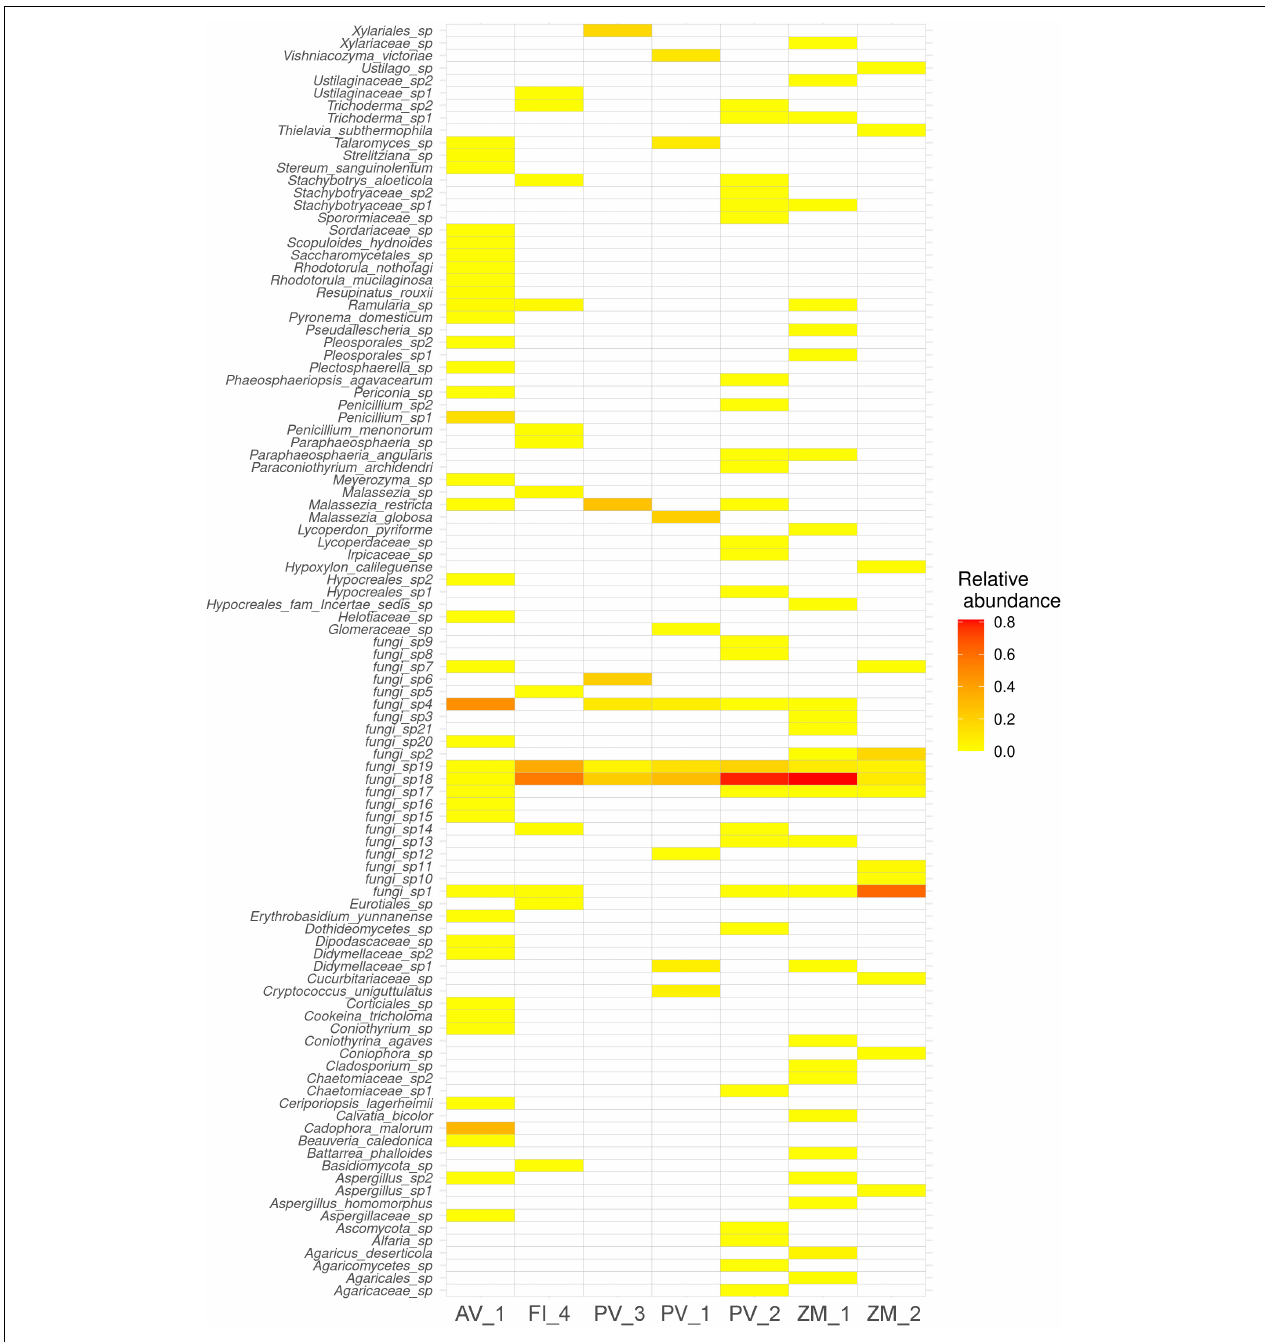
FIGURE 3 | Heatmap (red-white) showing sediment fungal richness and relative abundance at the species level across samples. The color intensity is proportional to fungal relative abundance, with red indicating higher